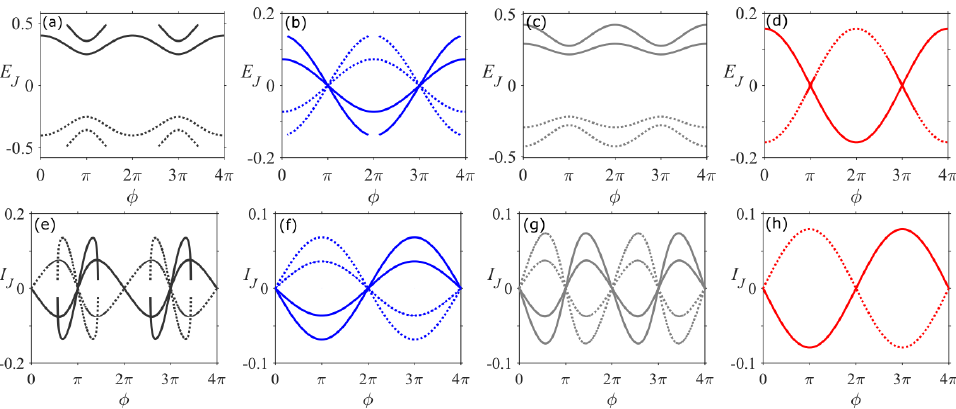
( φ ) and (e)-(f) Josephson current I J